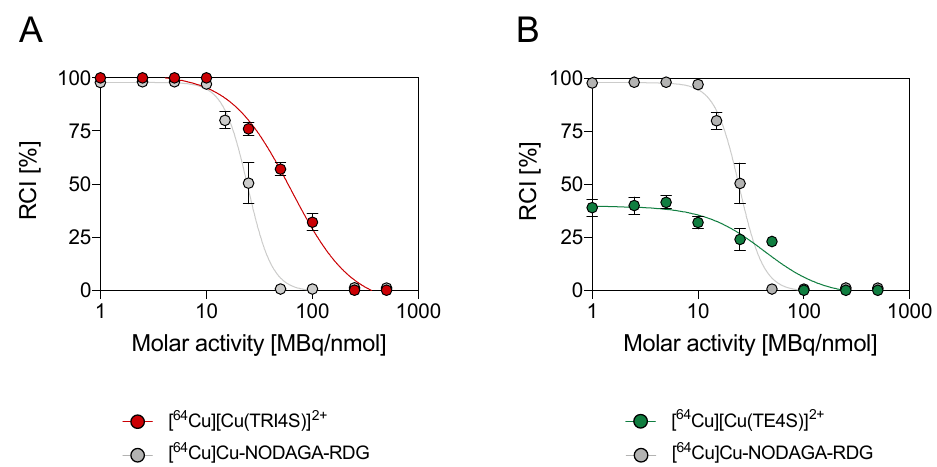
Figure 4. [ 64 Cu]Cu 2+ incorporation yields (10 min, pH 7 and RT) at different molar activities for ( A ) TRI4S and ( B ) TE4S. Incorporations are compared with those obtained with NODAGA-RDG under the same conditions.